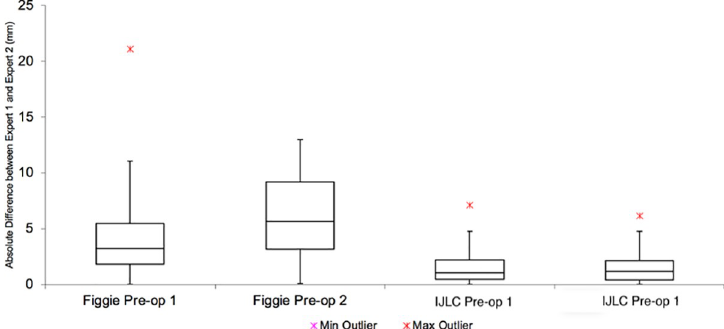
Fig 3. Boxplot demonstrating the differences between measurements performed by senior orthopaedic surgeon 1 and 2 on pre-operative radiographs.